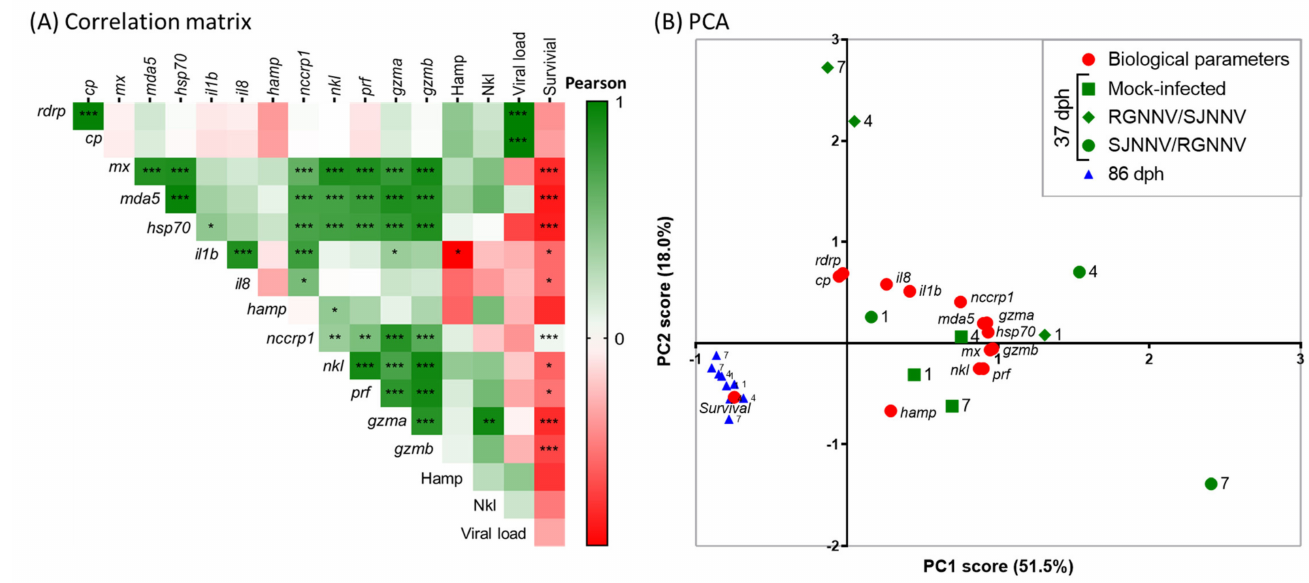
Figure 5. Different gene correlations and age clusters are observed in seabream larvae upon reas- sortant infection. Correlation ( A ) and principal components analysis (PCA) ( B ) of the mean gene transcription, peptide levels, viral load and survival in 37 and 86 days post-hatching (dph) seabream larvae infected by immersion with 10 4 TCDI 50 / mL of RGNNV/SJNNV or SJNNV/RGNNV reas- sortants at 1, 4 and 7 days post-infection (dpi). ( A ). Mean values of the parameters were correlated and the Pearson index presented in a heatmap (*, p < 0.05; **, p < 0.01; ***, p < 0.001). ( B ). PCA score plot, showing two components explaining 71.5% of the variance, based on the mean values of biological parameters (gene expression and survival). Colors and shapes denote the infection group and numbers the infection time. rdrp , NNV RNA-dependent RNA polymerase; cp , NNV coat protein; mx , interferon-induced GTP-binding protein Mx; mda5 , melanoma differentiation-associated protein 5; hsp70 , heat-shock protein 70; il1b , interleukin 1 beta; il8 , interleukin 8; hamp , hepcidin antimicrobial peptide; nccrp1 , non-specific cytotoxic cell receptor protein 1; nkl , NK-lysin; prf , perforin; gzma , granzyme A; gzmb , granzyme